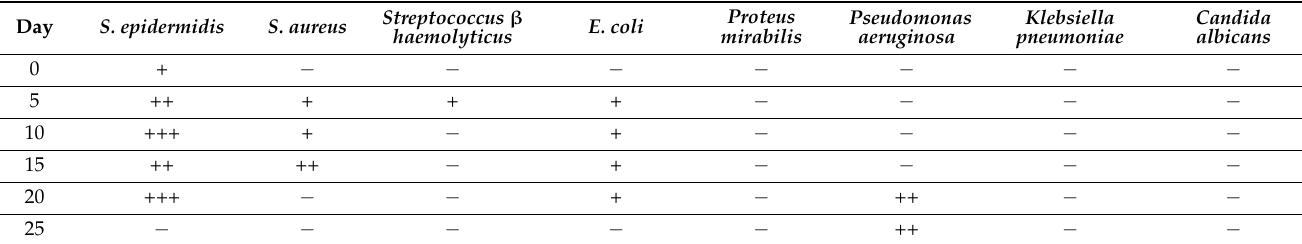
Table 2. Identification of healthy skin pathogens in pig II.